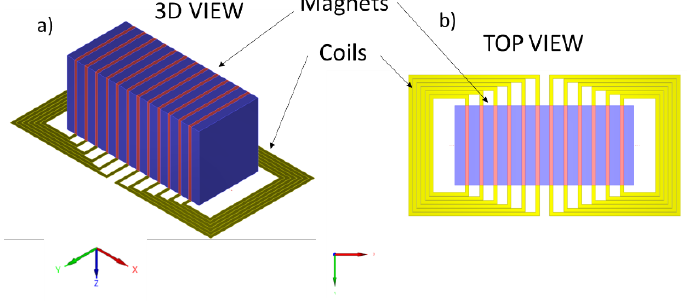
Figure 5. ( a ): 3D view of the EMAT. ( b ): top view of the EMAT.